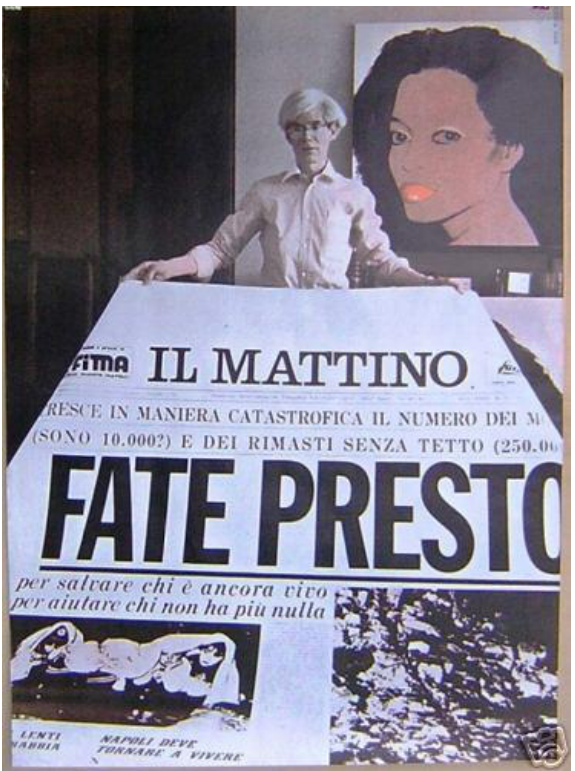
Figure 3. The front page of “Il Mattino” newspaper (26 November 1980) transformed by Andy Warhol into a pop art manifesto [33].